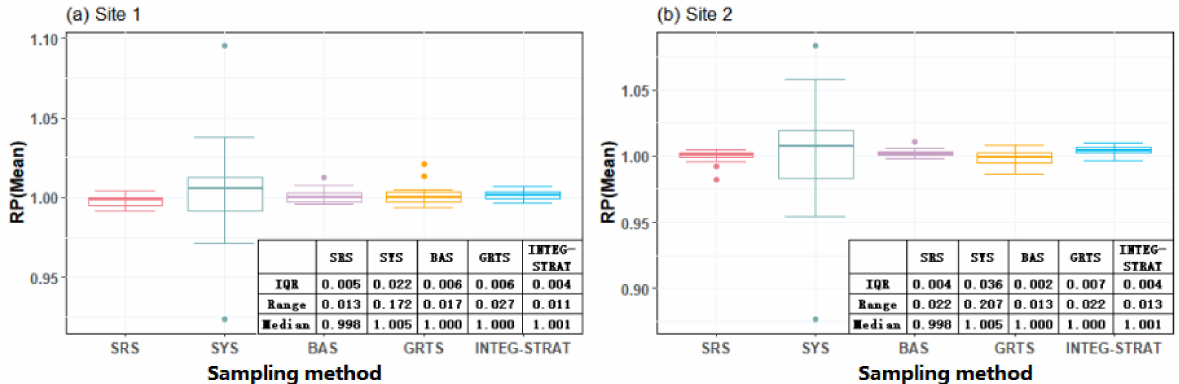
Figure 5. Boxplot of averaged RP mean of 100 simulations for each sampling method with sampling size from 20 to 200: ( a , b ) represent the RP mean for sites 1 and 2,